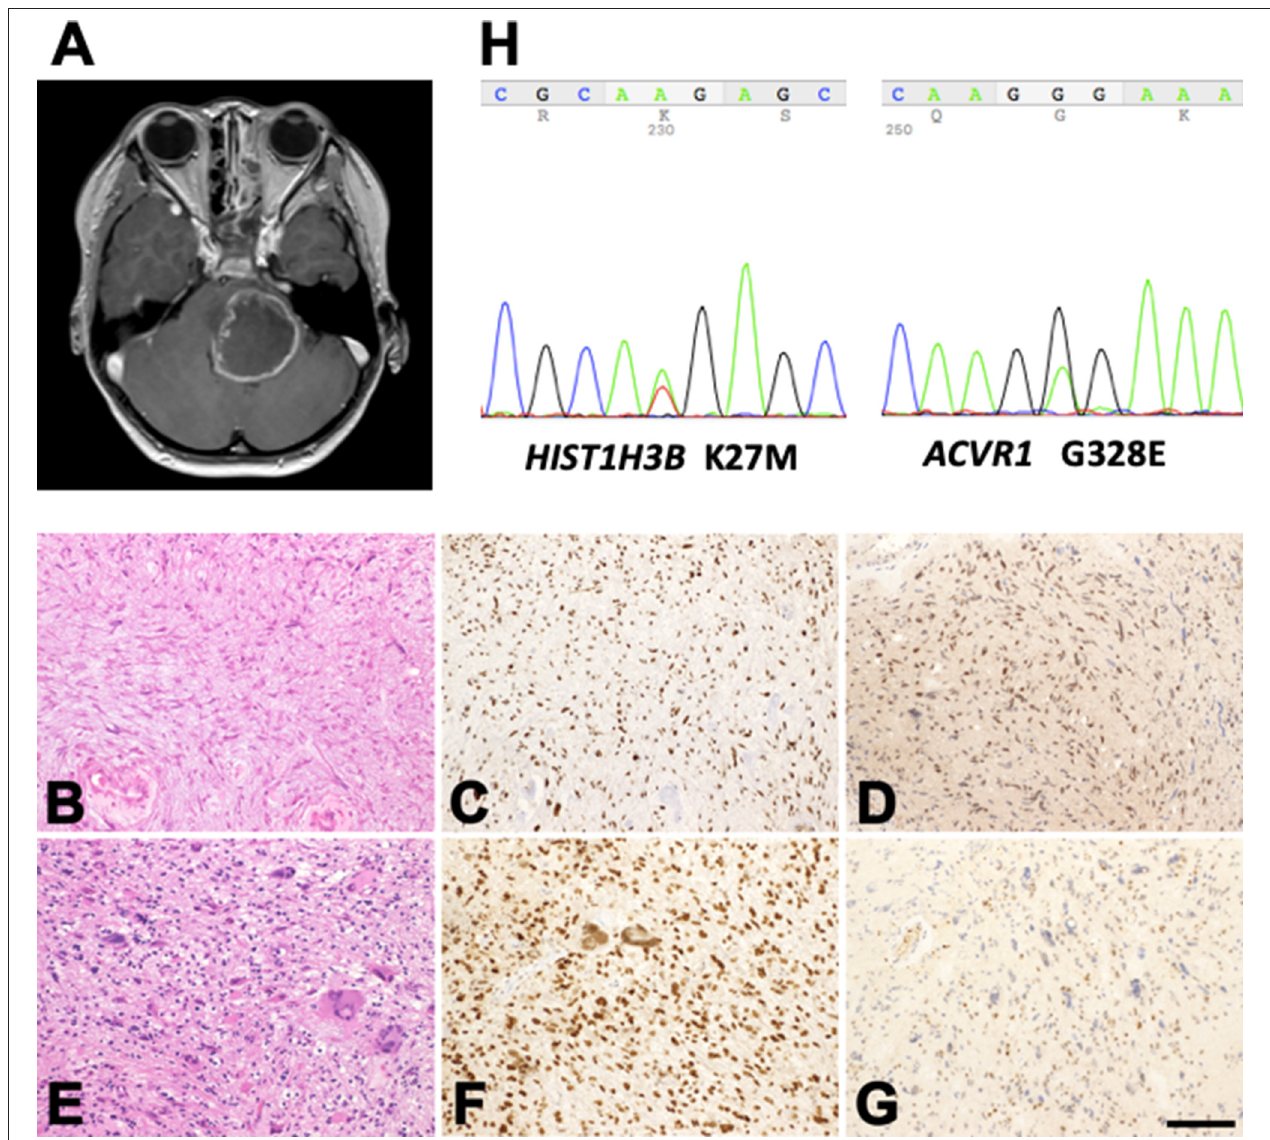
FIGURE 1 | Profile of the patient with H3K27M-mutant diffuse midline glioma. (A) Post-contrast MR images disclose a large mass lesion involving the pons. (B–G) Histology and immunohistochemistry of the surgical specimens taken at the first (B–D) and second (E–G) operations. (B) Astrocytic tumor cells with fine processes. (E) Tumor cells with marked nuclear atypia. (C,F) Histone H3K27M-immunohistochemistry. A large proportion of the tumor cell nuclei in the specimens taken at both operations are positive. (D,G) MGMT-immunohistochemistry. The proportion of positive nuclei in the specimens at the first operation is large (D) , but that in the specimens at the second operation is small (G) . (B,E) Hematoxylin and eosin staining. Bar = 120 µ m for (B–G) . (H) K27M mutation in HIST1H3B and G328E mutation in ACVR1 in the tumor tissue removed during the second operation.